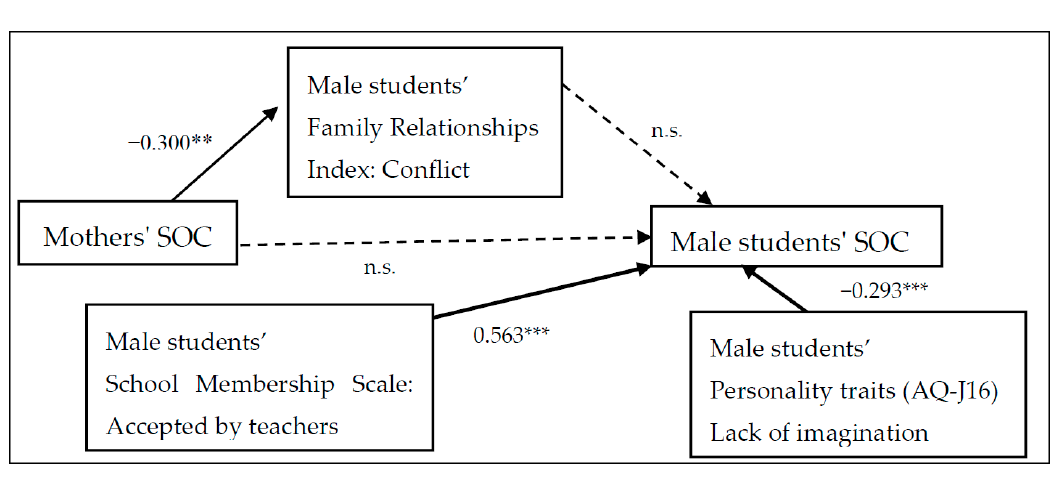
Figure 1. Male students’ SOC path diagram. RMSEA = 0.069, Comparative Fit Index (CFI) = 0.908, χ 2 / df = 1.95. *** p < 0.001, ** p < 0.01.